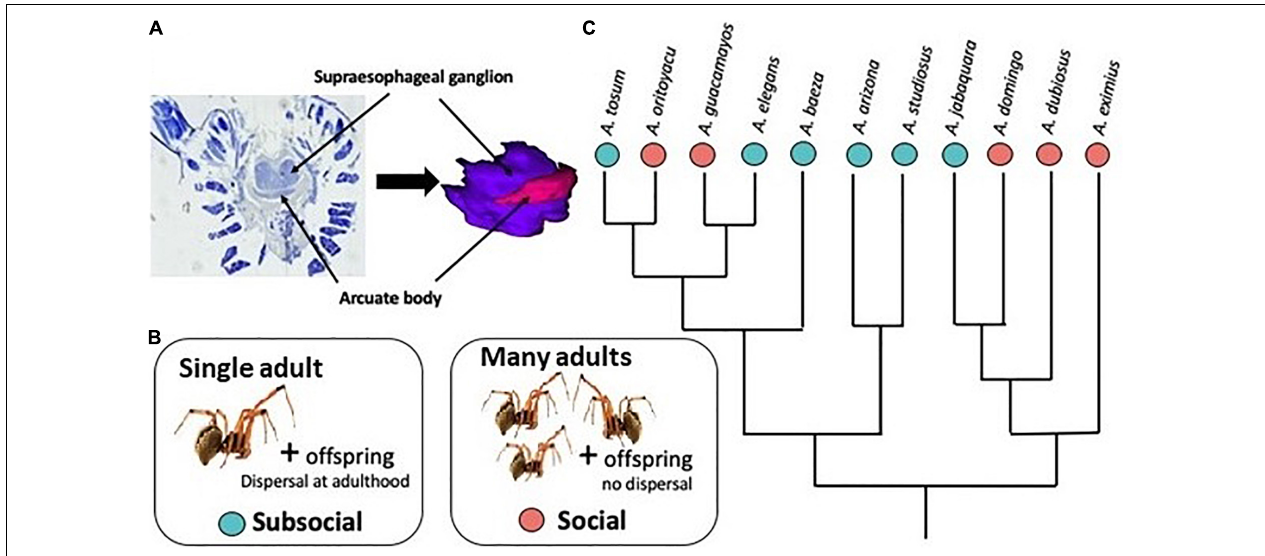
FIGURE 1 | (A) Light photomicrographs of stained and sectioned protocerebrum tissue, showing supraesophageal ganglion (SEG) and arcuate body (AB) regions. The 3D reconstruction shows the relative sizes of the SEG (purple) and AB (pink). (B) Brain volume was compared between subsocial (blue) species, which form nests of single mothers and their offspring, who disperse at adulthood, and social (pink) species, which form permanent communal nests with multiple mothers and offspring. (C) Phylogenetic relationships among the sampled species (Luo et al., 2020).